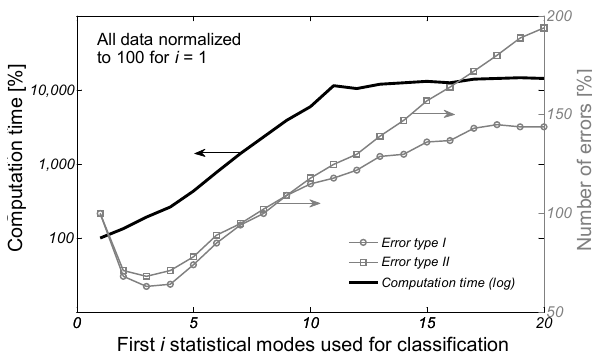
Figure 9. Normalized plot of computation time and number of oc- curring errors for classification for the GFRP sample based on the first i statistical